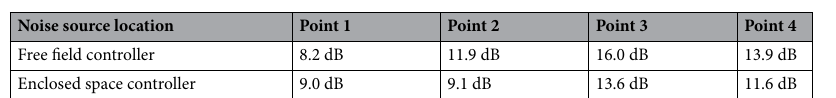
Table 1. Noise reduction of the controllers designed in the free field to minimize the acoustic power and in the enclosed space to minimize the acoustic potential energy when the noise source is located at the center point, depending on the location of the noise